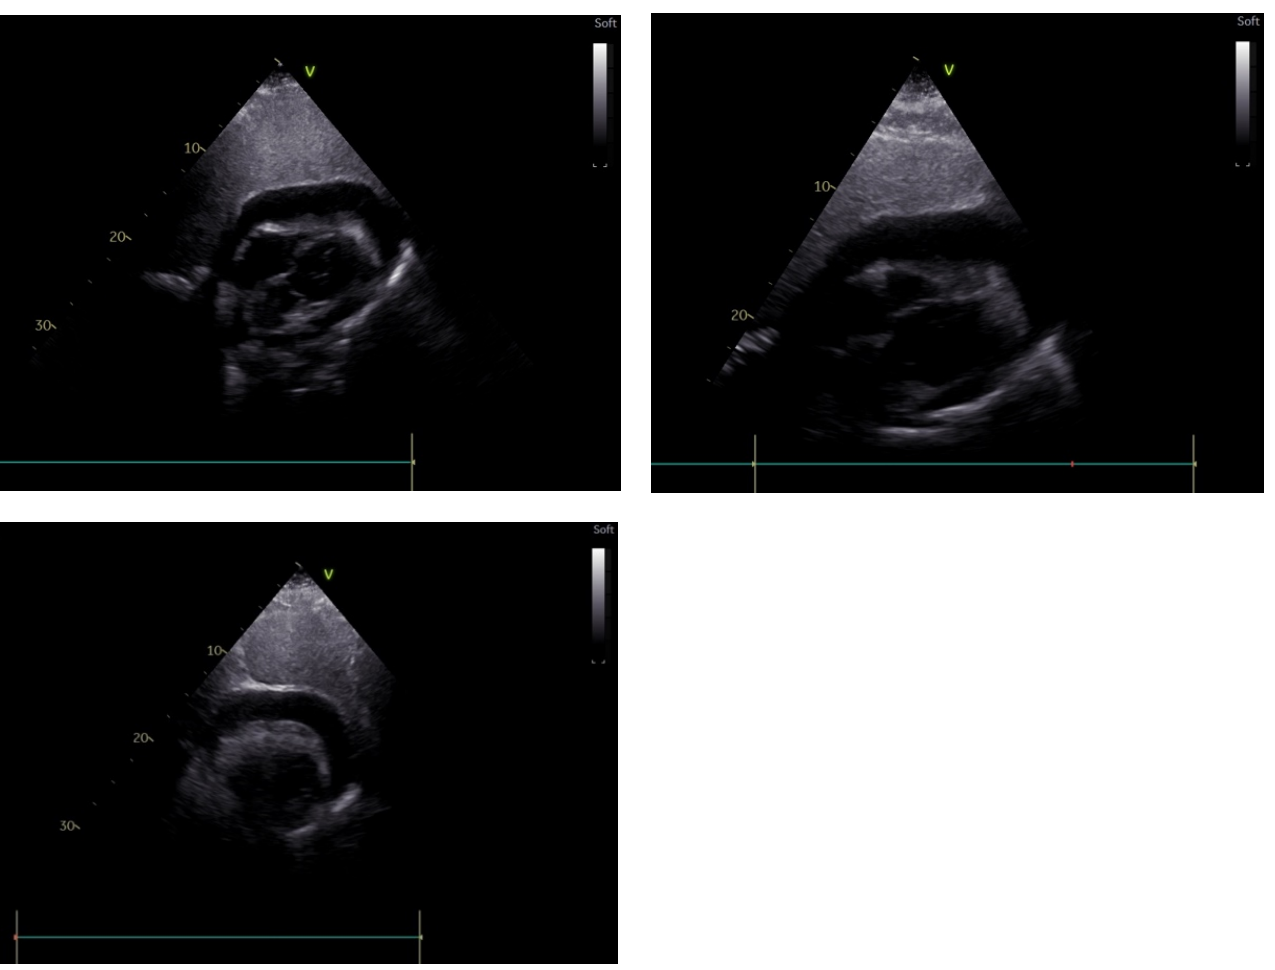
Figure 2. Transthoracic echocardiogram showing a large pericardial effusion (most prominent around the left ventricular posterior wall and the left ventricular apex with about 2.7 cm and 2.4 cm in diameter, respectively) with a ventricular systolic collapse and a ‘’swinging heart’’ view.